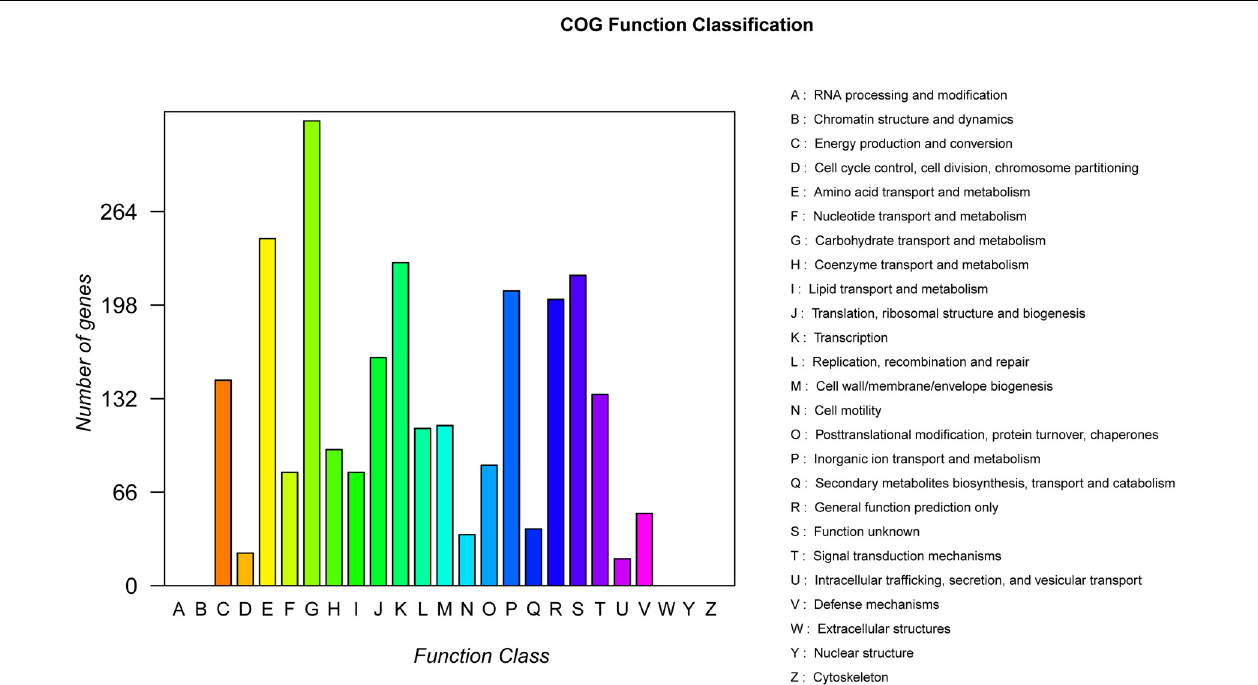
FIGURE 2 | Distribution of genes across COG functional categories in the chromosome of P. polymyxa strain HY96-2.